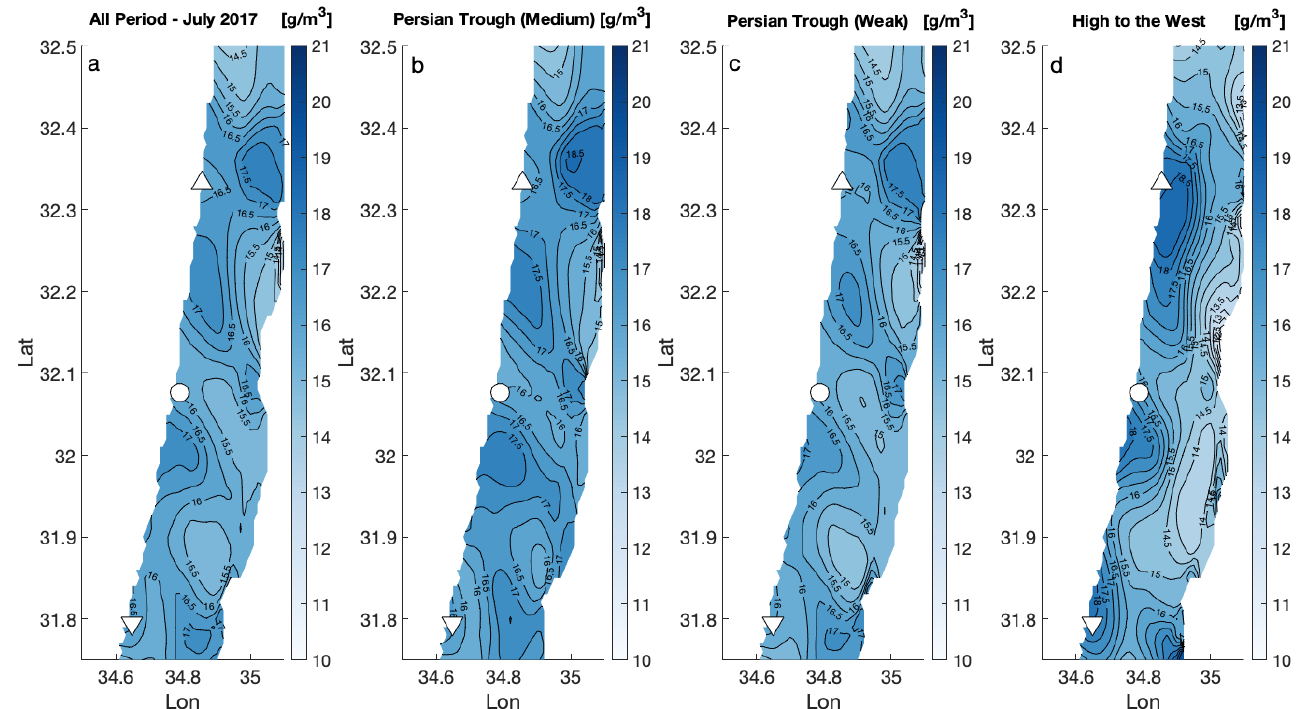
Figure 4. Average humidity maps for the whole period during July 2017 ( a ) and for three synoptic conditions: medium Persian Trough ( b ), weak Persian Trough ( c ), and High to the West ( d ). Maps ( b – d ) show the interpolated humidity fields based on 10 km radius of interpolation. White circles denote the coastal cities of Tel Aviv; white triangles are the coastal cities of Netanya (upward) and Ashdod (downward).